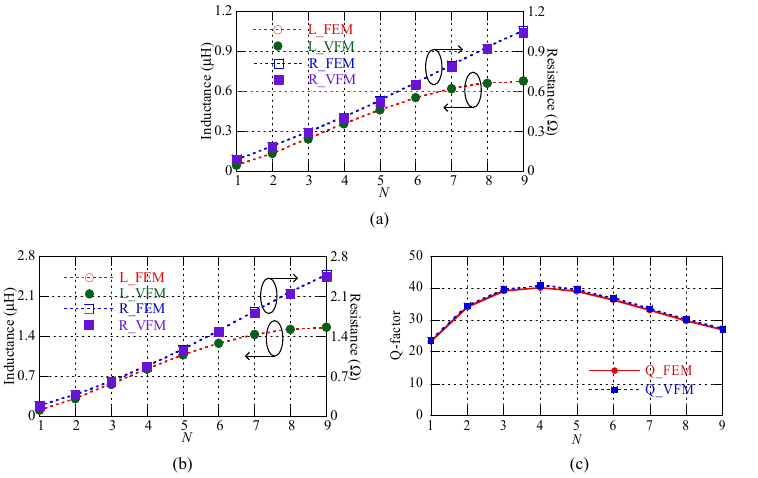
Figure 5. The calculations and simulations of resistance (R) and inductance (L) according to N for ( a ) double-layer and ( b ) four-layer planar spiral coils with g = 0.15 mm. ( c ) Q-factor for the double-layer planar spiral coil.